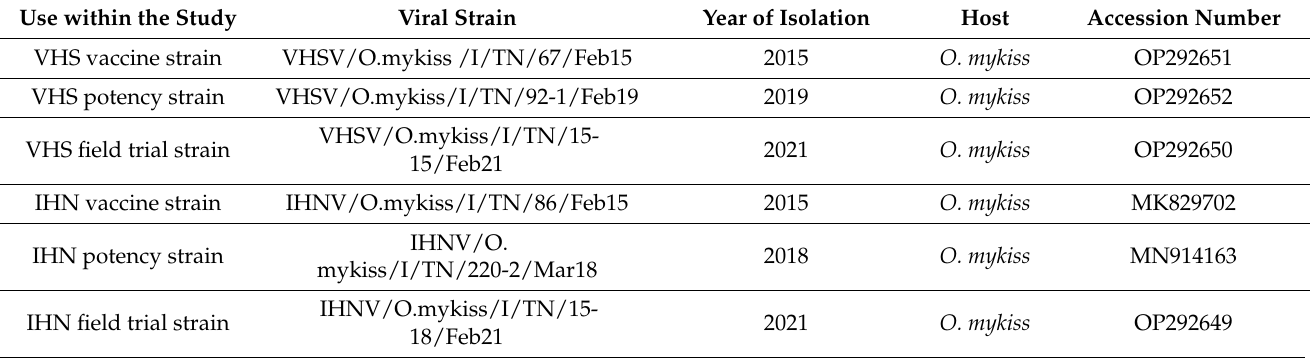
Table 1. Viral strains and GenBank accession numbers for G gene